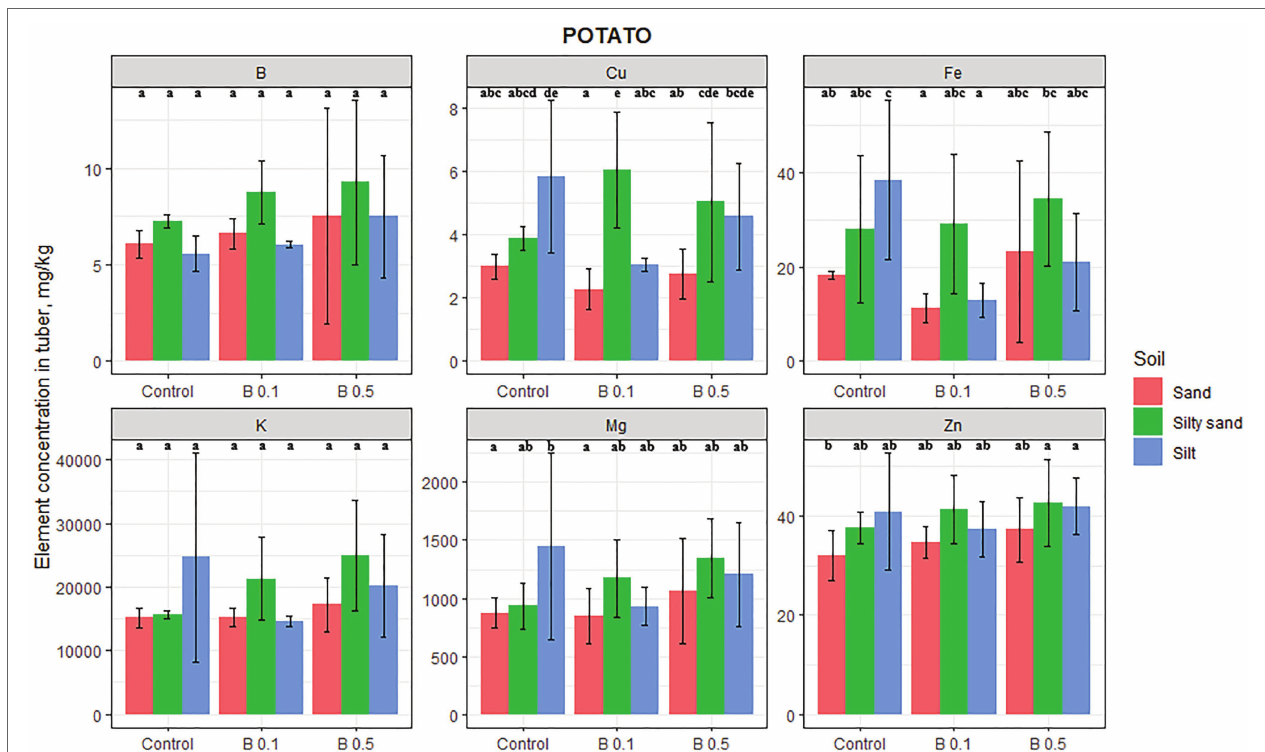
FIGURE 3 | Element contents in potato tuber in different irrigation water treatments on sand, silty sand, and silty soil (mg/kg DW). The data are means of the replicates. Different letters (a–e) indicate significant differences between treatments ( p <